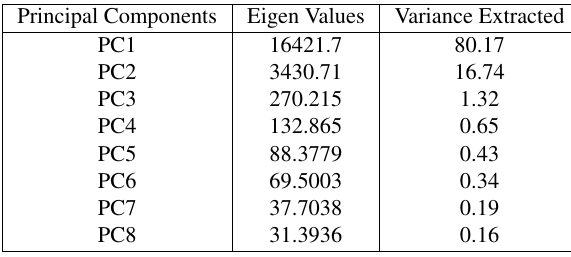
Table 2: Eigen values and percentage information in